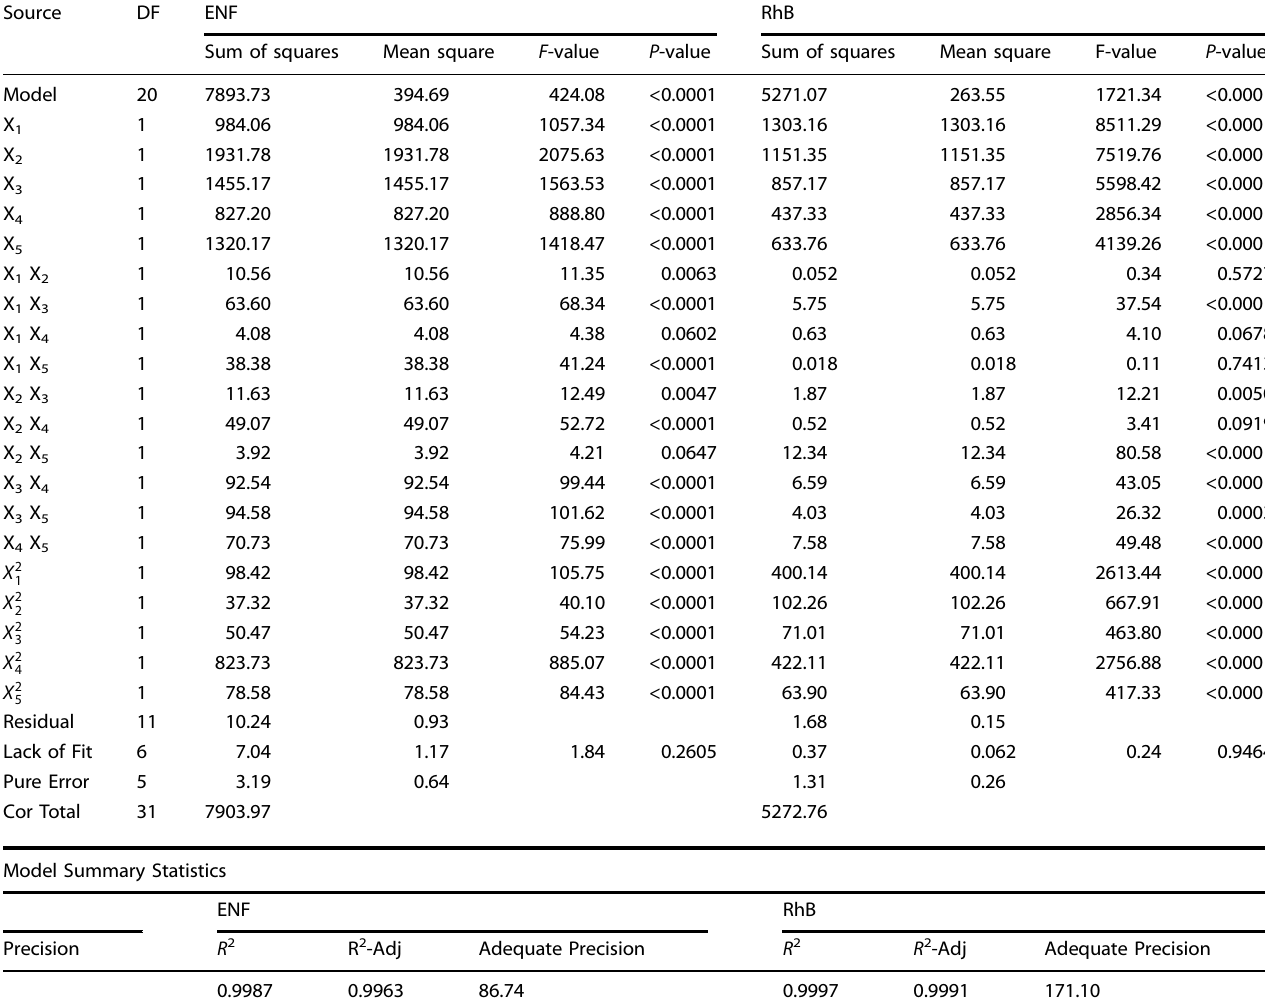
Table 2. Analysis of variance (ANOVA) results of remove ENF and